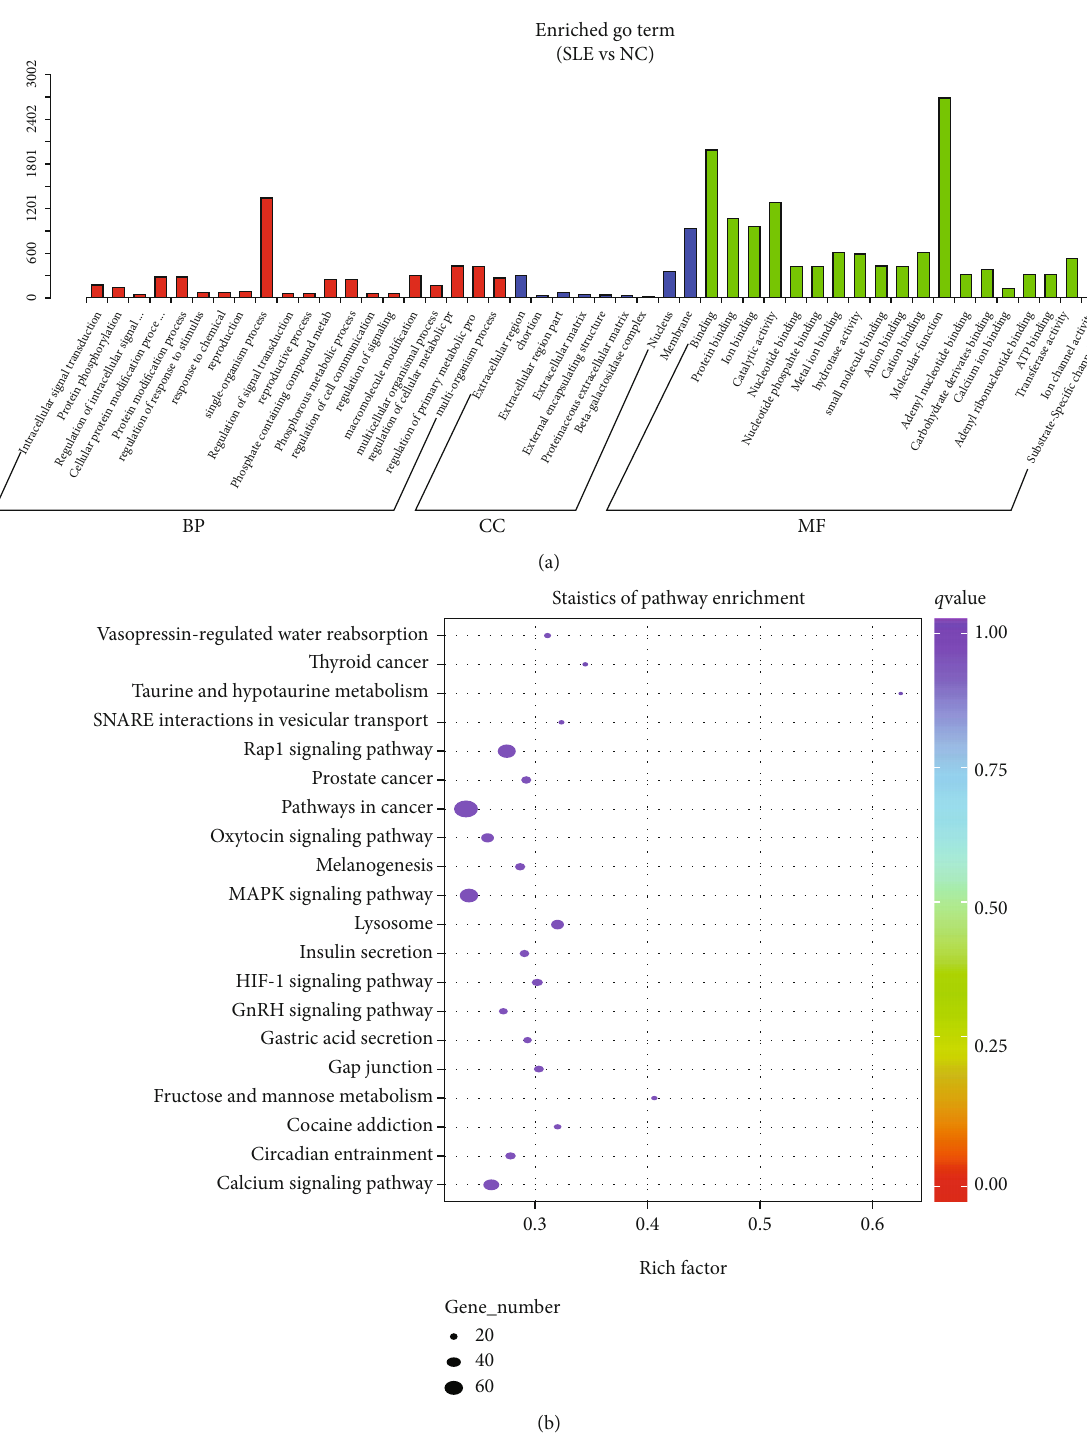
Figure 3: GO and KEGG enrichment analyses of the di ff erentially expressed miRNAs. (a) GO enrichment analysis showed that the di ff erentially expressed miRNAs were correlated with various biological processes such as molecular function, protein binding, and nucleotide binding activity. (b) KEGG enrichment analysis revealed the involvement of the di ff erentially expressed miRNAs in various pathways such as cancer, MAPK signaling, and Rap1